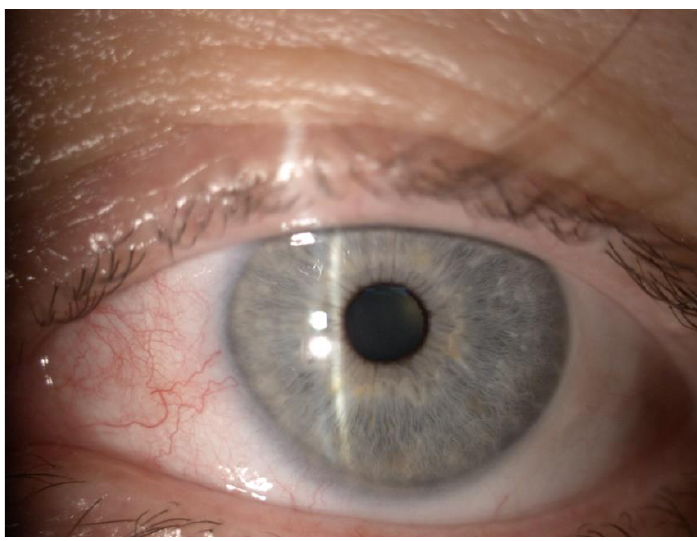
Figure 2. Eye of the patient with episcleritis with onset during COVID-19